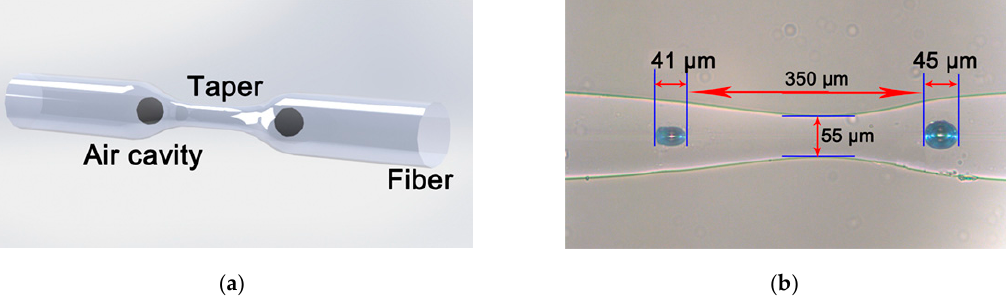
Figure 2. ( a ) Schematic diagram of fiber taper based Mach–Zehnder interferometer (MZI); ( b ) optical microscope image of one sample. Table 1. Geometric dimension of two samples.